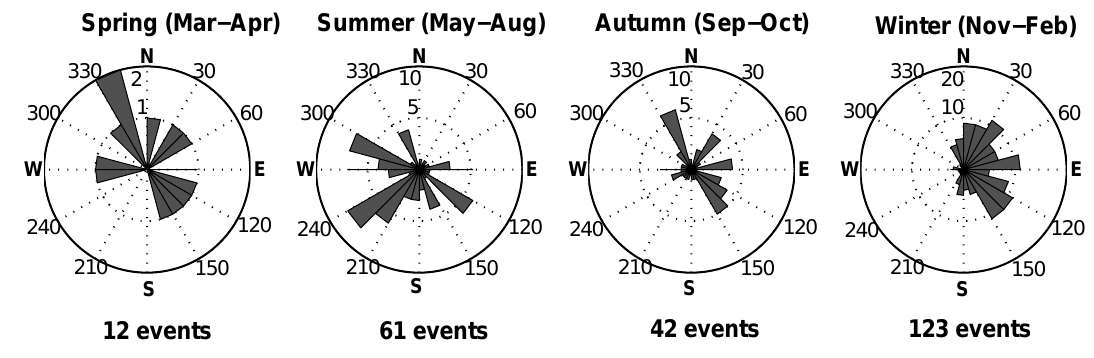
Fig. 10. Seasonal variations of the movement directions of ripples.